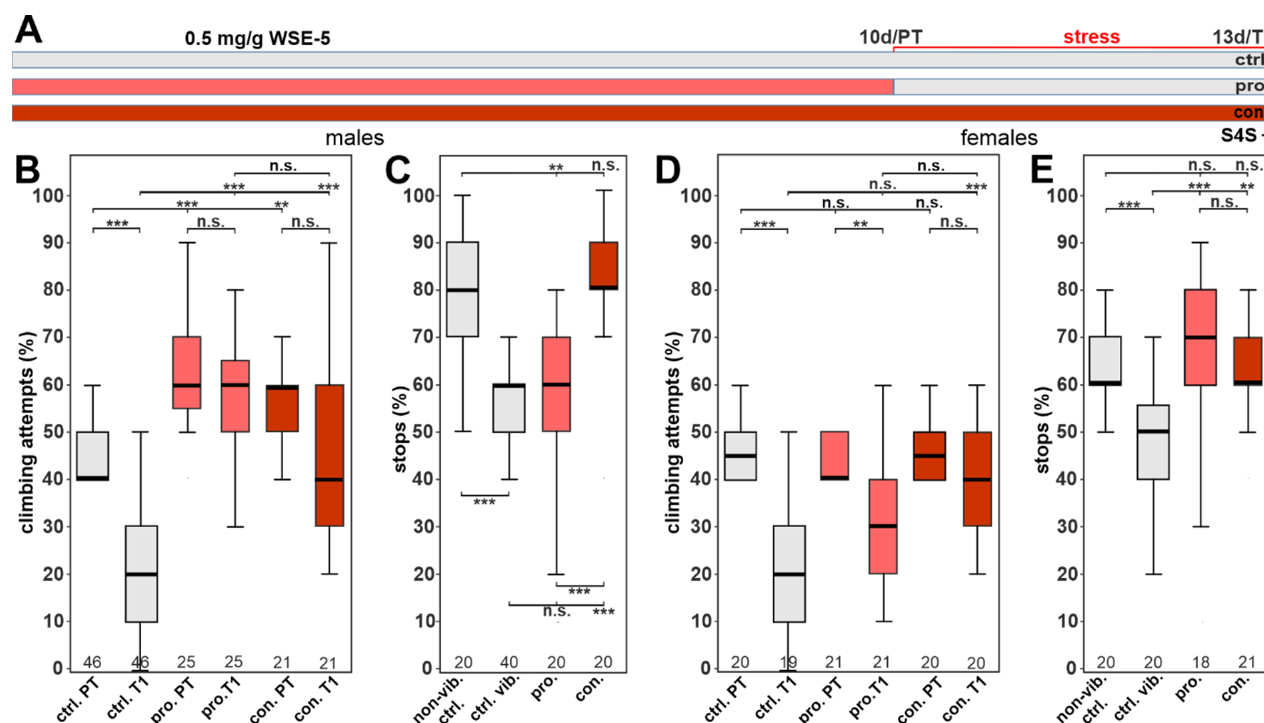
Figure 8. WSE-5 partially protects against stress-induced behavioral phenotypes at 0.5 mg/g. ( A ) Schematic of the treatment paradigm (the time of WSE-5) treatment is indicated in red. ( B ) Percent of climbing attempts of males before (PT) and after stress (T1) was applied. ( C ) Number of stops males made at the sweet-tasting stripe. ( D ) Percent of climbing attempts of females before and after stress was applied. ( E ) Number of stops females made at the sweet-tasting stripe. A pairwise Wilcoxon test with Bonferroni–Holm correction for multiple comparisons was used in each panel. The number of analyzed flies is given below the boxes. The horizontal bars in the box plots represent the medians, boxes the 25% and 75% quartiles, and whiskers the data points within ± 1.5 times the interquartile range (IQR). S4S = stop for sweet test, ctrl. = control, vib. ctrl = vibrated control, non-vib. ctrl. = non-vibrated control, pro. = prophylactic treatment, con. = continuous treatment. ** p < 0.01, *** p < 0.001, n.s. = not significant.